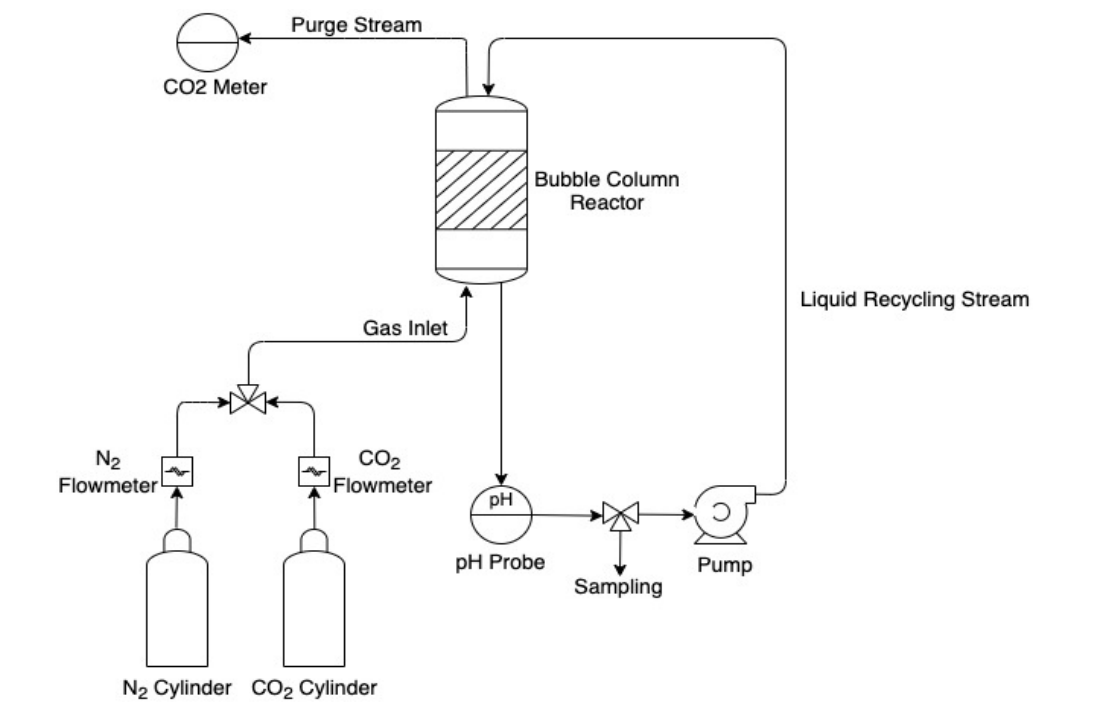
Figure 1. Experimental setup used for CO 2 absorption experiments.